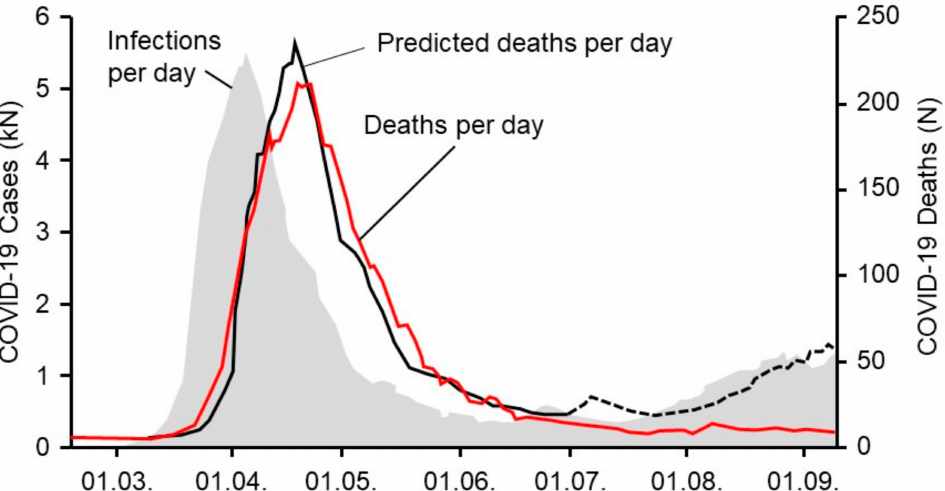
Figure 2. Time series analyses performed on the temporal incidence of SARS-CoV-2 infections (grey area, left scale) and the incidence of COVID-19-associated deaths (red line, right scale). A prediction model (black line, right scale) for COVID-19-associated deaths based on actual incidences was estimated for Germany. The model fit is excellent for the first part of the pandemic. After June 2020, the incidence of new infections started to rise and re-peaked and the model predicted a similar increase for expected deaths based on data from the spring (black dotted